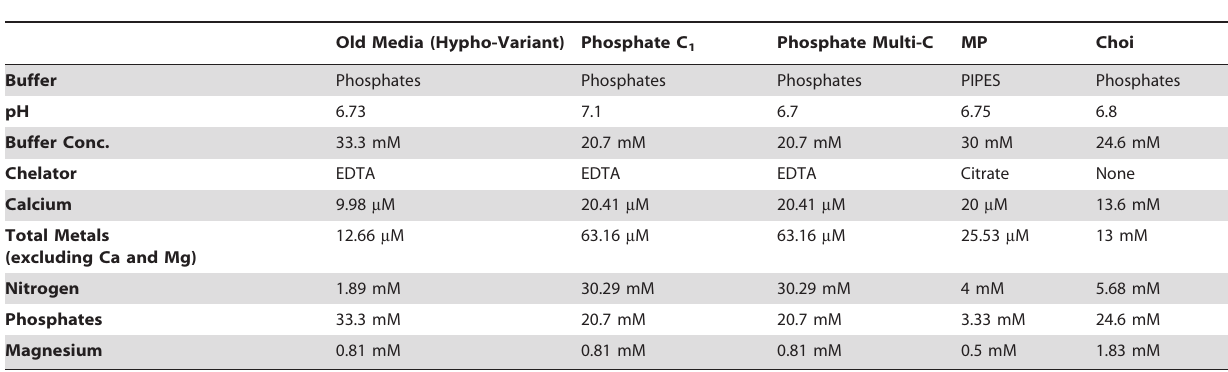
Table 2. Comparison of the main components of the different mediums.